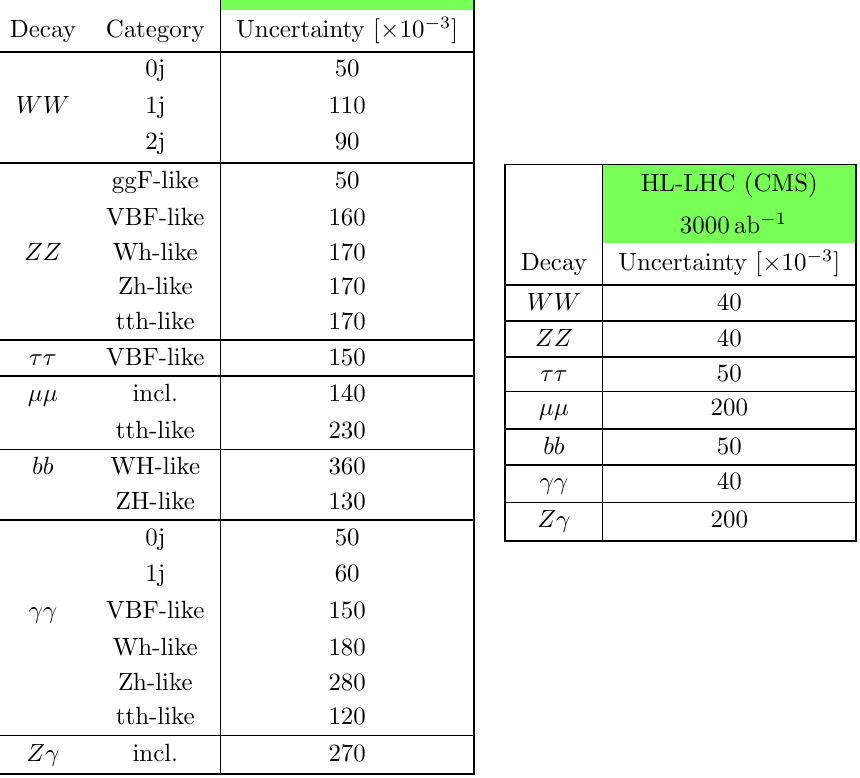
Table 7 . Inputs for the Higgs-boson signal strength’s uncertainties at the HL-LHC from AT- LAS [147{149] and CMS